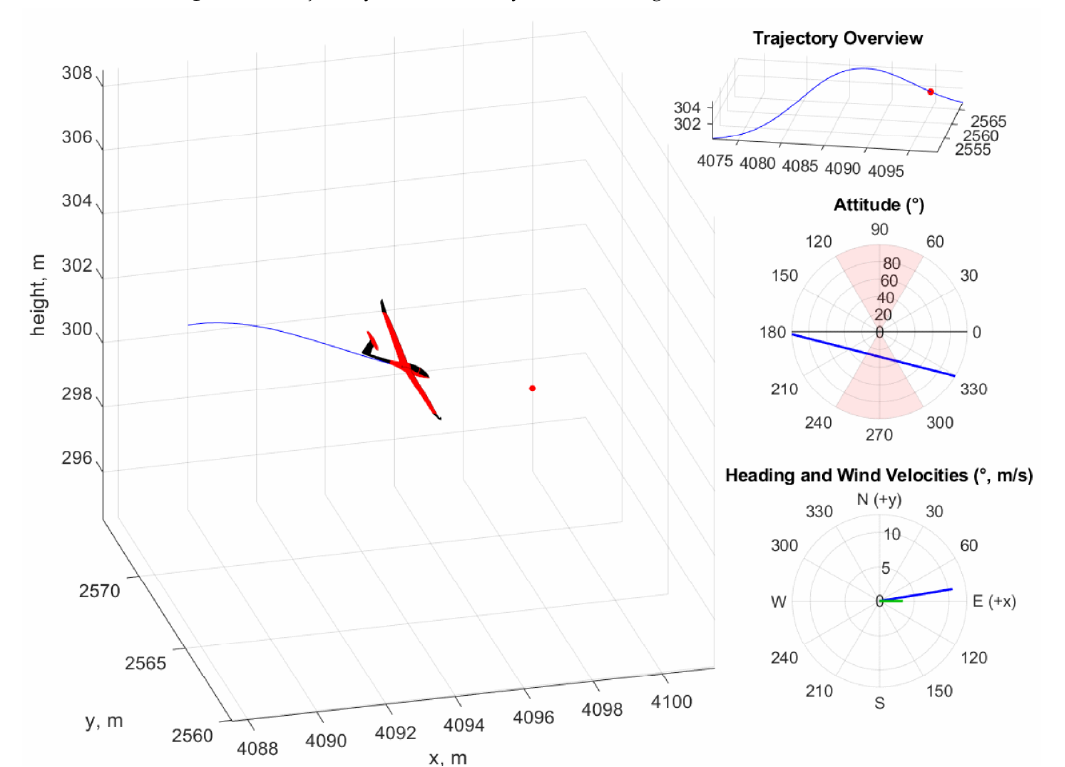
Figure 16. Aircraft visualization of the dynamic soaring SUAV neurocontroller (Supplementary Materials). The attitude indicator displays the roll angle along its circumference, as well as the pitch angle through the concentric circles within the plot. The shaded red zones represent the roll angle limits. The heading and wind velocities are shown by the blue and green vectors, respectively, where their orientations indicate direction and their lengths indicate the